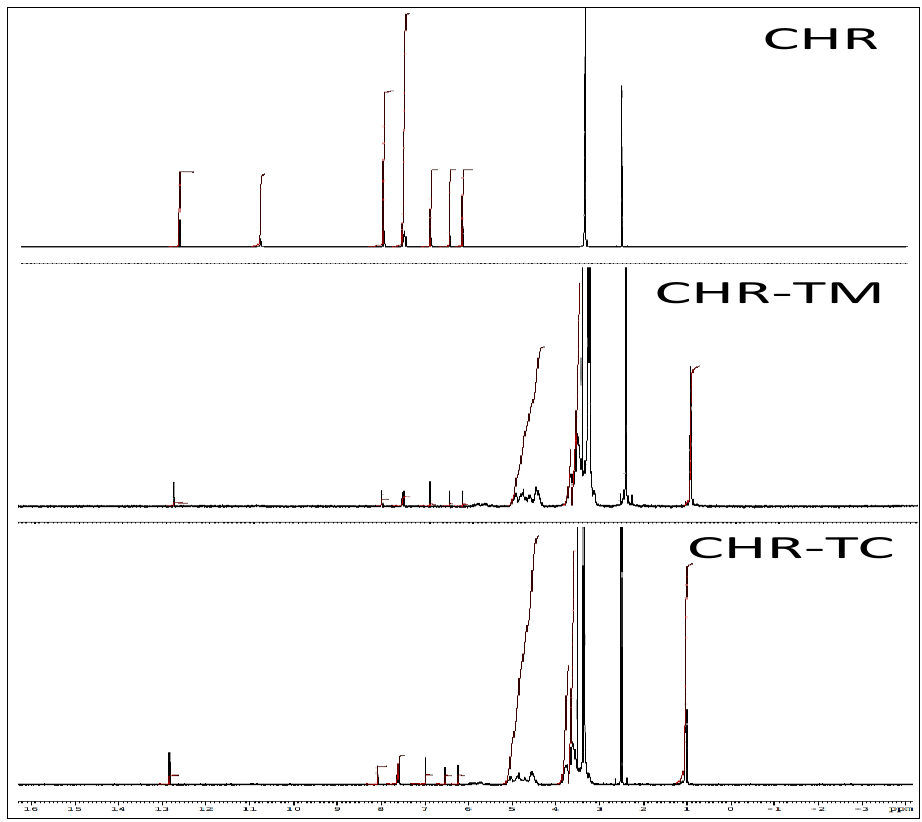
Figure 5. Spectra of pure Chrysin (CHR), Chrysin ternary mixture (CHR-TM), and Chrysin ternary complex (CHR-TC).